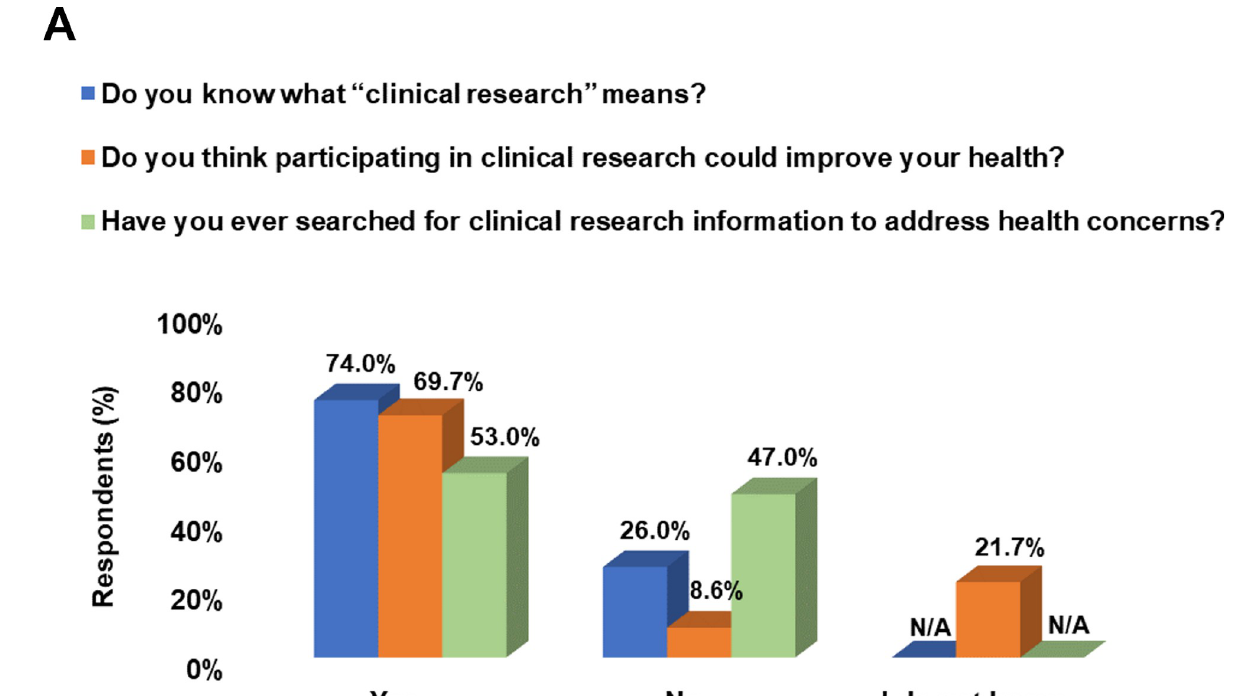
Fig 1. Assessment of participants’ awareness and understanding of clinical research. (A) Bar graph showing participants’ awareness of clinical research, its role in promoting health, and their clinical research information seeking behavior. (B) Clinical research information sources participants used or would use to address health-related concerns. All responses are reported as percentages out of the total (N = 1061).